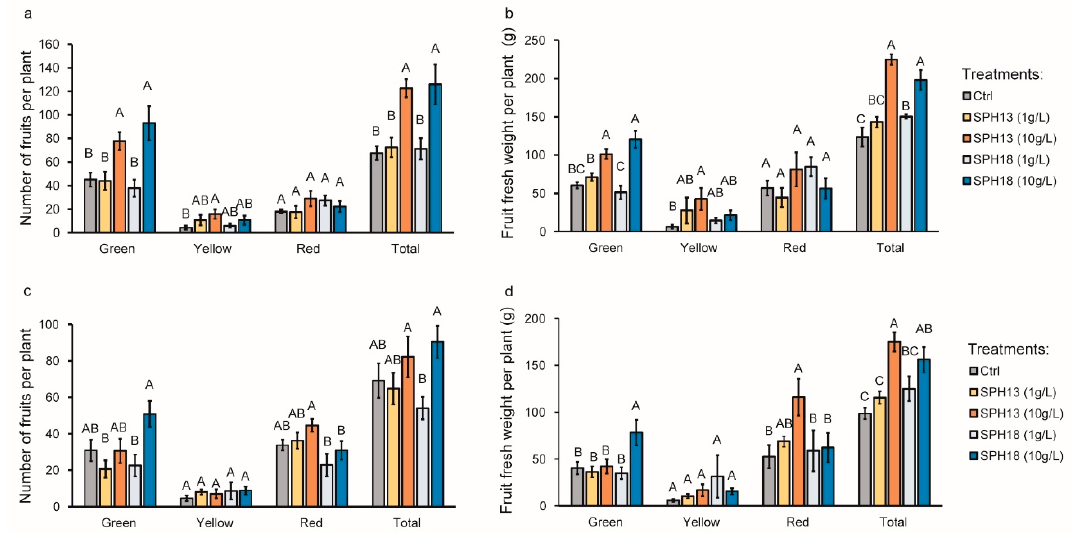
Figure 2. ( a – d ) Fruits from Micro Tom plants were harvested 9 weeks after two successive treatments ( a , b ) or 10 weeks after one treatment ( c , d ) with SPHs and sorted according to their colour. Average fruit number ( a , c ) and biomass in g ( b , d ) of the green, yellow, red, and total fruits produced per plant ( n = 5, one-way ANOVA with post hoc LSD; statistical analysis was performed for each fruit colour separately, p < 0.05, means with the same letter are not significantly different). The growing cycles started on 11 July 2021 for ( a , b ) and on 3 February 2022 for ( c , d ). We hypothesized that, by decreasing the quantity of SPH applied on plants, we could achieve higher red fruit production within a 16-week-long growing cycle. Therefore, the experiment was repeated but with only one soil drench application. The fruits were harvested 10 weeks after treatments to determine their effects on fruit productivity (Figure 2c,d). Interestingly, SPH13 and SPH18 at 10 g L − 1 increased the total fruit number per plant by only 19 and 31% (not significant at p < 0.05), while raising significantly the total fruit weight per plant by 58 and 77%, respectively. Similarly to the first experiment, SPH18 at